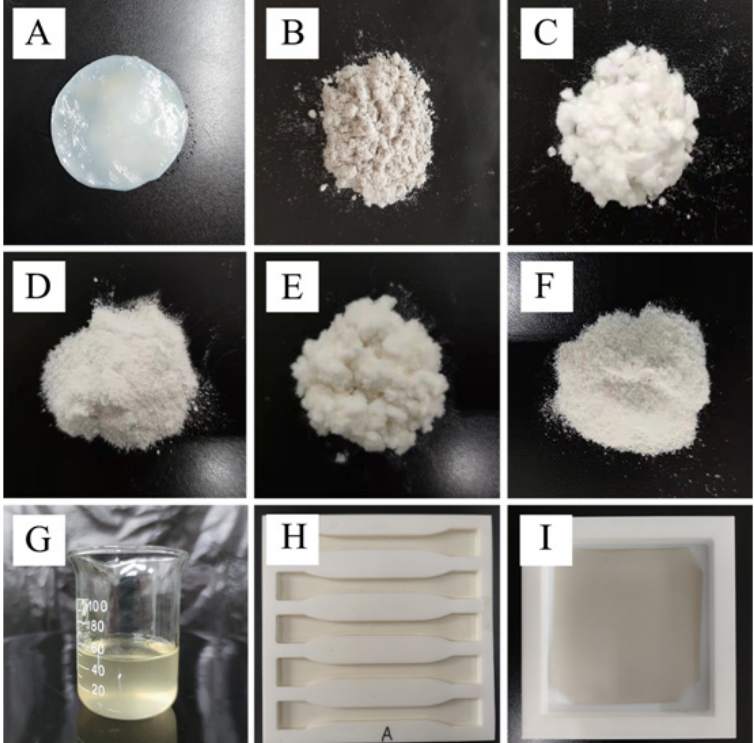
Figure 1. Examples of ( A ) Wet BC, ( B ) Dry BC powder, ( C ) Cellulose-C, ( D ) Cellulose-H ( E ) Cellulose-B, ( F ) CMBC, ( G ) CMBC solution, ( H , I ) CMBC composite films.